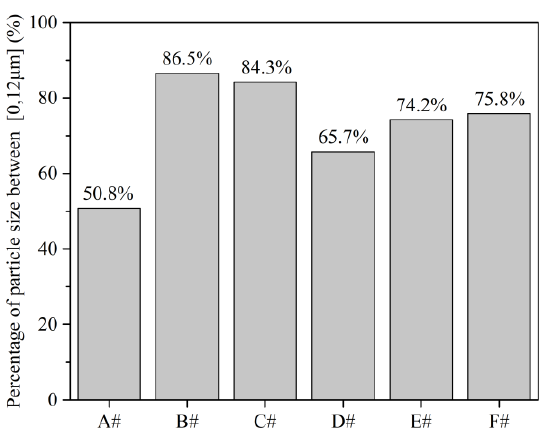
Figure 4. Percentage of small-size high impact polystyrene (HIPS) particles for various screws.